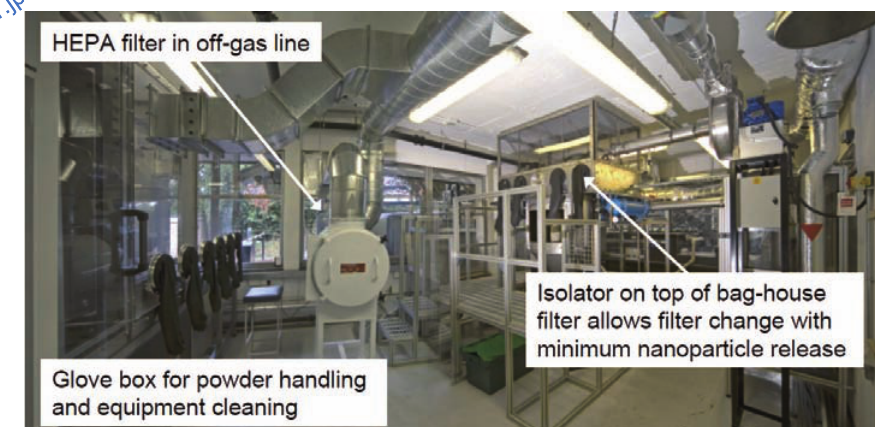
Fig. 8 FSP pilot plant at Johnson Matthey Technology Center located in a fully enclosed production space accessed only through an air lock. Workplaces for nanopowder handling inside the room are equipped with glovebox